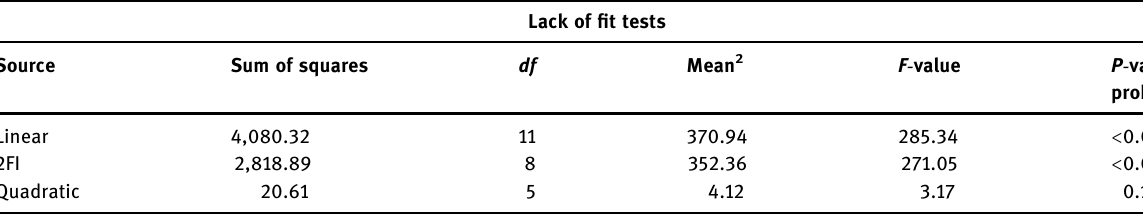
Table 5: Fit summary for FCCCD for biosorption of Ni 2 + ions by Gelidium amansii biomass from aqueous solution